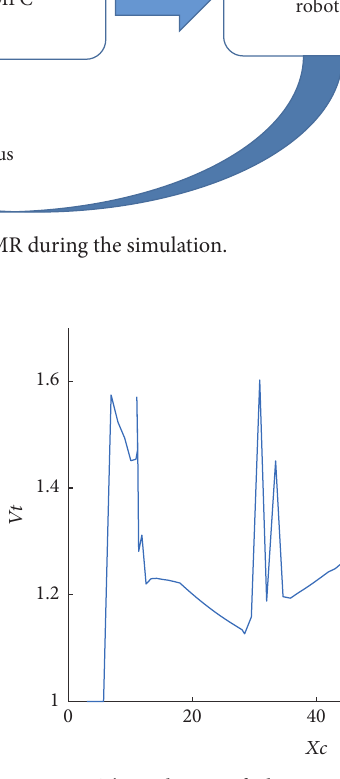
Figure 8: The velocity of the OMR controlled by kinematic controller during the simulation.